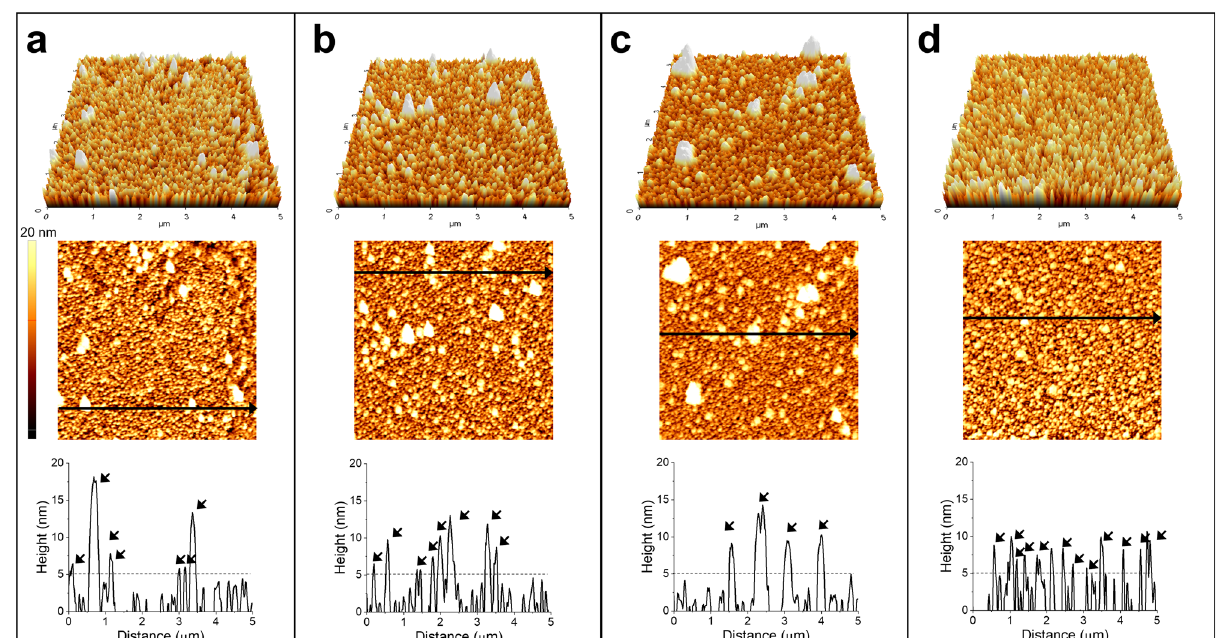
Fig. 4 Assembly properties of the enzymes on the planar gold surface. AFM images for a the native CODH-L, b CODH-L gbpN , c CODH-L gbpC , and d CODH-L gbpNC immobilized on the planar gold surface. The corresponding cross-sectional pro fi les along the indicated arrows are shown in the lower panels. The arrows indicate the location of the enzyme on the surface.